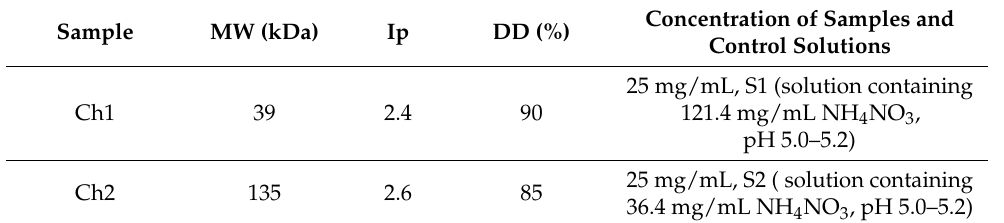
Table 1. Characteristics of the used Ch